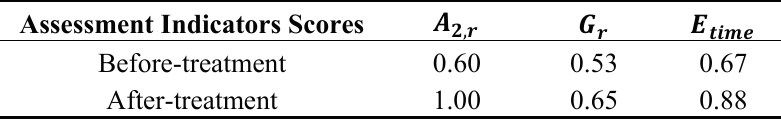
Table 2. Calculated indicators for Case 2—A stroke